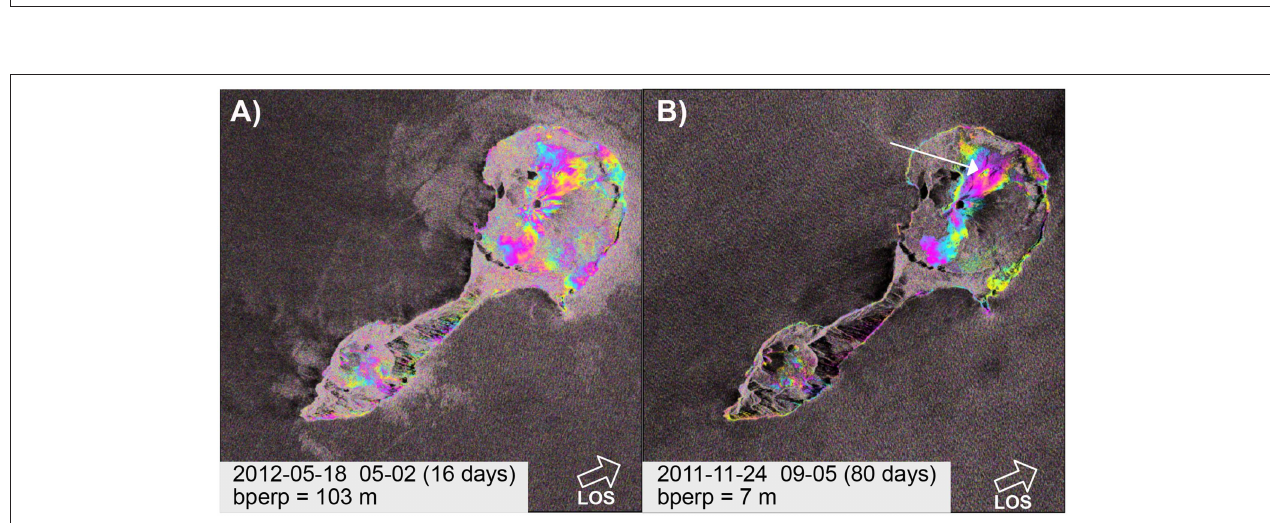
FIGURE 8 | Stack of 22 interferograms from Envisat track 102 showing mean line-of-sight deformation between 2004/11/16 and 2006/01/10. White contour represents the mapped extent of scoria deposits from Trusdell et al. (2006).